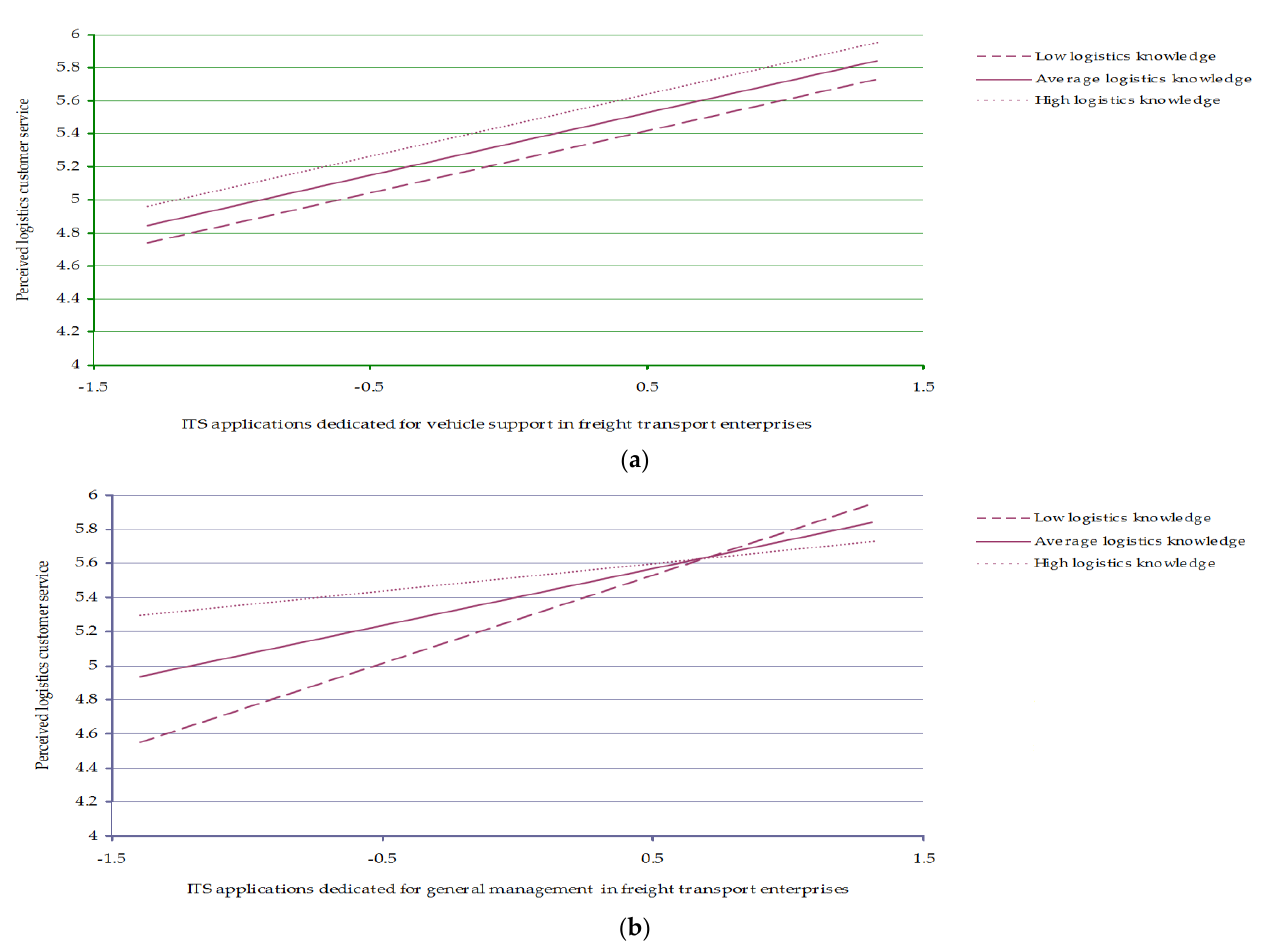
Figure 4. Moderating effect of logistics location for: ( a ) ITS applications dedicated to vehicle support in road freight transport enterprises, ( b ) ITS applications dedicated to general management in road freight transport enterprises.